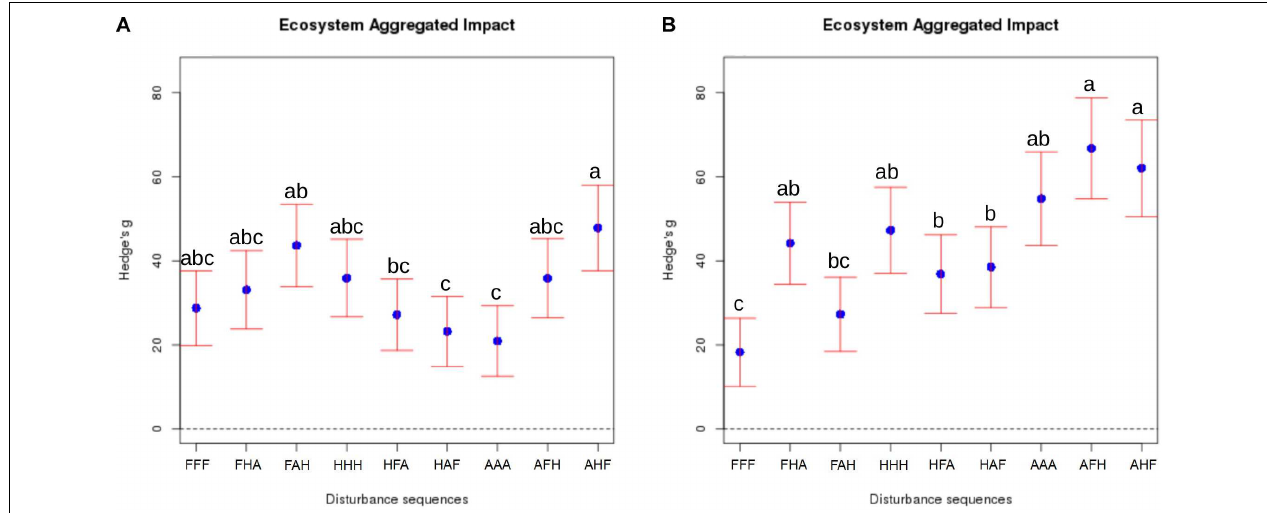
FIGURE 2 | Aggregated impact of compounded disturbances with alternative chronologies on ecosystem properties and functions. The “Ecosystem Aggregated Impact” was calculated as the sum of the absolute value of Hedges’ g for all studied variables. The corresponding variance is the sum of the variance of each variable Hedges’ g. 95% confidence intervals are represented for each treatment. Panel A corresponds to T 3 and panel B to T 4 , Disturbance sequences are encoded with F: Freeze-thaw, H: Heat and A: Anoxia. Note that the control treatment cannot be plotted on this figure because each EAI is calculated as an effect size of a given treatment relative to the control. Different letters above the bars indicate significant differences.